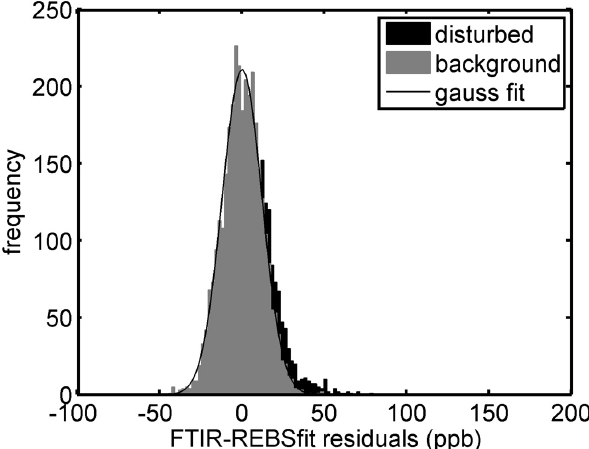
Fig. 4. Histogram of filtered background (grey) and rejected disturbed (black) FTIR-REBS residual data using REBS-CNR filtering.